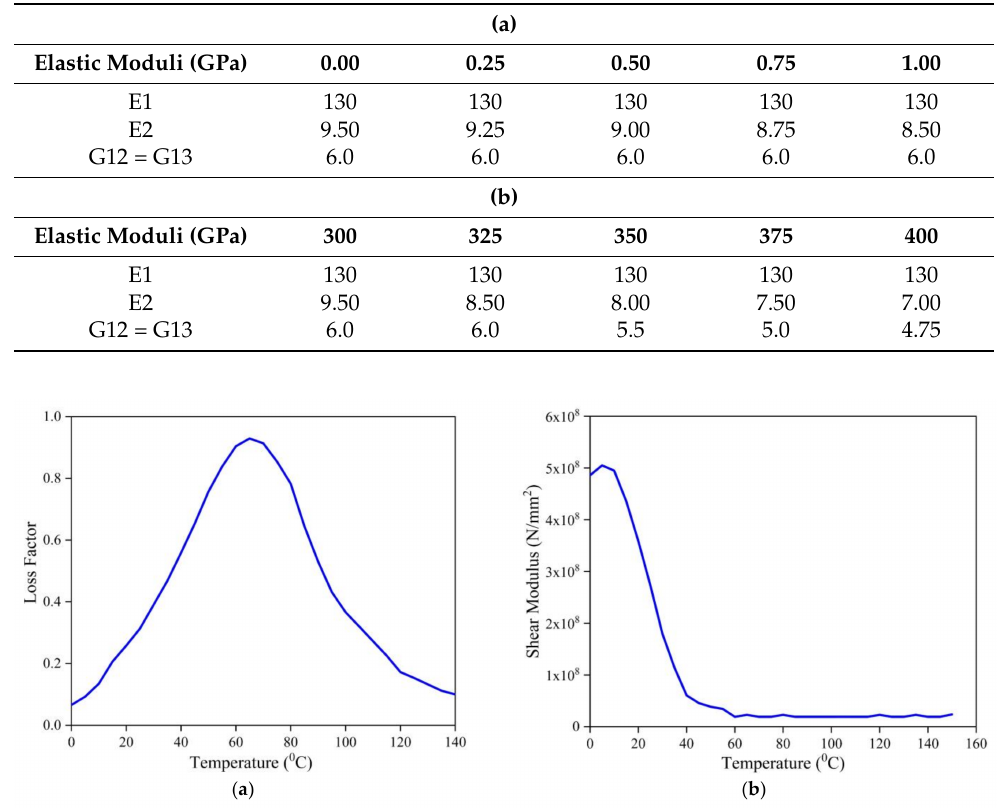
Figure 2. Properties of DYAD 606 viscoelastic material ( a ) loss factor and ( b ) shear modulus varia- tions [10] (Adapted with permission from Elsevier B.V., License Number: